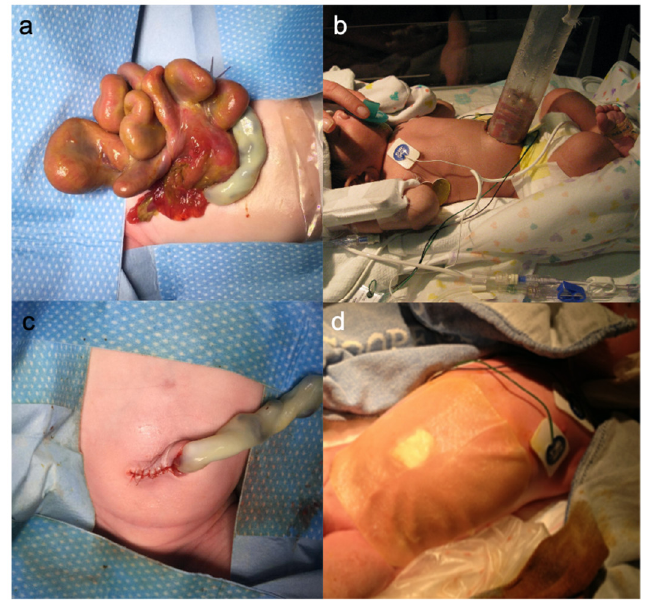
Figure 1. Gastroschisis: ( a ) Herniated intestine and greater omentum; ( b ) Silo treatment; ( c ) Abdominal wall after sutured closure; ( d ) Sutureless closure.